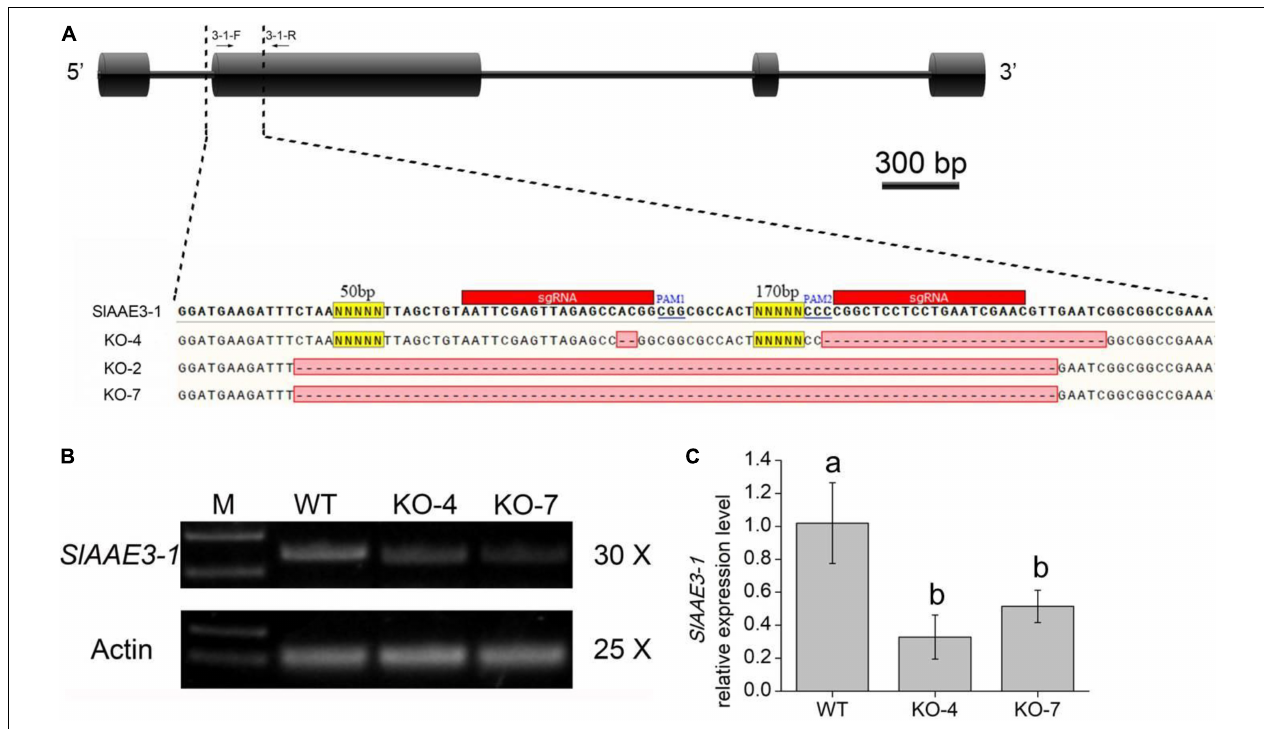
FIGURE 4 | MicroTom T1 mutants were obtained via CRISPR/Cas9-mediated gene editing. (A) Gene structure and mutation sites of SlAAE3-1 . Black boxes and horizontal lines between the boxes indicate exons and introns, respectively. Black arrows indicate PCR primers used to evaluate mutation type and efficiency. Two sgRNA were used to knock out SlAAE3-1 and the PCR products from a subset of plants were cloned and sequenced to validate the deletion in plant KO-2, KO-4, and KO-7. (B) PCR gel showing the type of DNA lesions generated in the genome, and (C) qRT-PCR analysis revealing the expression level of SlAAE3-1 of KO-4 and KO-7 plants. Error bars indicate mean values ± SD ( n = 3). Different letters on vertical bars indicate significant difference at p < 0.05 using one-way ANOVA.